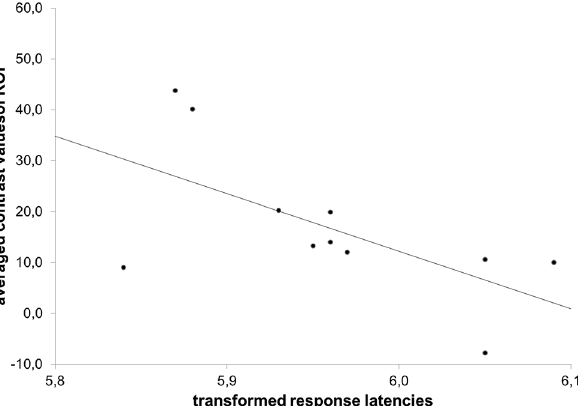
Fig 6. Correlation with ROI contrast values: the scatter plot demonstrates the significant correlation between averaged ROI contrast values of dACC activation and the associated log-transformed means of response latencies of the positive self-related traits.